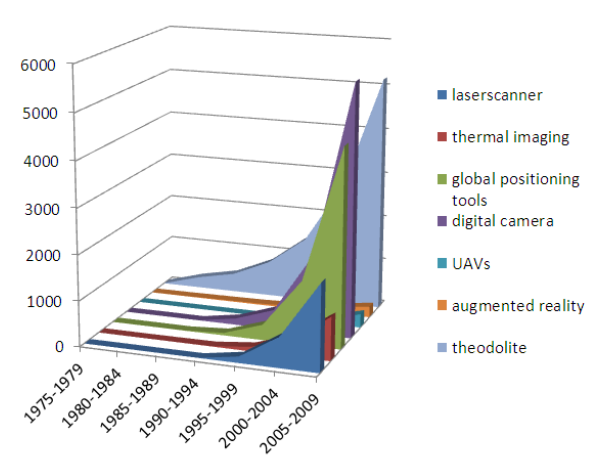
Figure 1. Number of articles published concerning advanced technology for documentation in five year segments. This article graph clearly shows an increase in the use technology (Eppich-Hadzic,